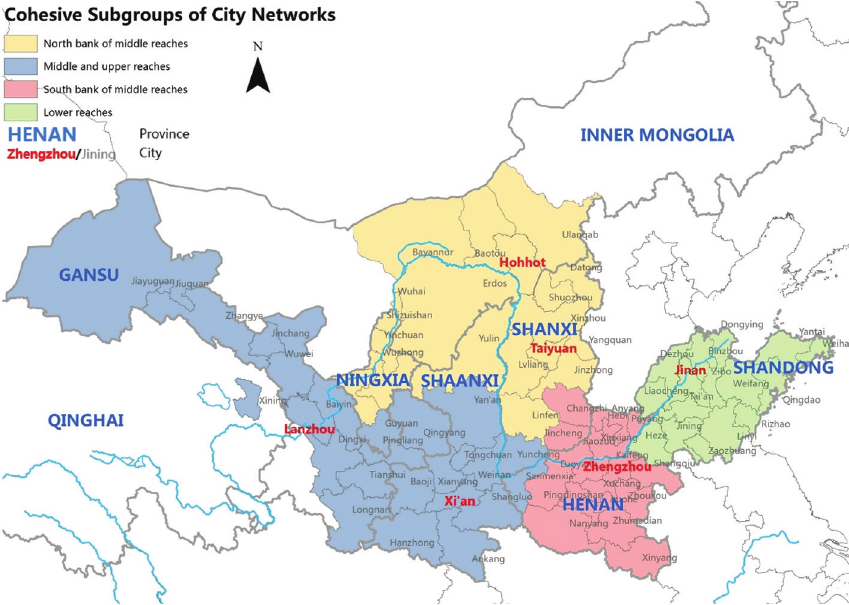
Figure 13: Spatial distribution of cohesive subgroups of city networks in the Yellow River